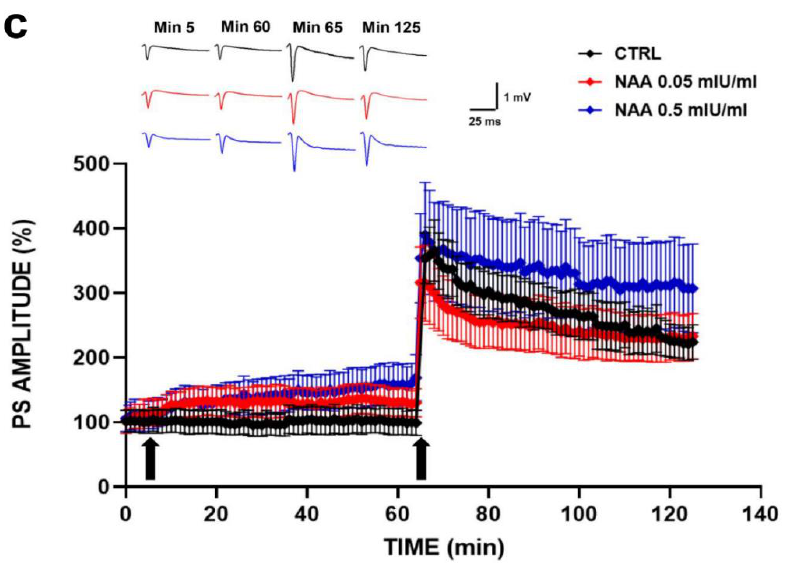
Figure 1. ( a ) Cell viability assessment in HT22 cells treated with increasing concentrations of Neuraminidase (NAA): the dose-response curve shows that in the concentration range between 0.005 and 0.5 mIU/mL, cell viability is not affected by treatment. A progressive reduction in cell viability is observed at higher concentrations, reaching the half maximal Inhibitory Concentration (IC50) at the dose of 10 mIU/mL. ( b ) Basal synaptic transmission (BST) in CA1 subfield of mouse hippocampal slices following NAA administration: % Population Spike (PS) amplitude as a function of time after NAA administration at different concentrations, applied at time t = 5 min (arrow), is shown in mouse hippocampal slices of five experimental groups (black line, CTRL n = 6; yellow line NAA 0.005 mIU/mL, n = 5; red line NAA 0.05 mIU/mL, n = 6; blue line NAA 0.5 mIU/mL, n = 6; green line NAA 10 mIU/mL, n = 4). The insert shows representative recordings obtained from slices of each experimental group; curves of each group refer to PS at times 5, 35 and 65 min. ( c ) Synaptic plasticity in CA1 subfield of mouse hippocampal slices following NAA administration: %PS amplitude as a function of time after tetanic stimulation (HFS), applied at time t = 65 min (arrow), following NAA administration at different concentrations ( t = 5 min, arrow) is shown in mouse hippocampal slices of three experimental groups (black line CTRL, n = 6; red line NAA 0.05 mIU/mL, n = 7; blue line NAA 0.5 mIU/mL, n = 7). The insert shows representative recordings obtained from slices of each experimental group; curves of each group refer to PS at times 5, 60, 65 and 125